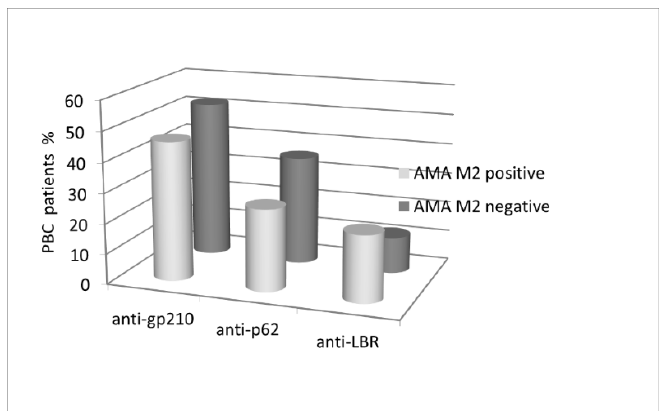
Figure 3. Prevalence of antinuclear antibodies in the studied AMA M2-positive and AMA M2-negative populations.